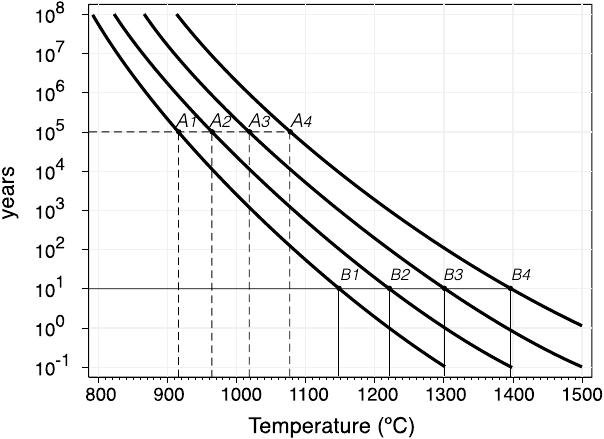
Figure 1. Time-temperature equivalences for Pb diffusion in zircon. The t-T coordinates along the same line result in identical diffusion profiles across two domains with different Pb concentration. The only difference between the four curves is they are suitable for different t-T combinations. For example, heating at 915 °C for 10 5 years (point A 1 ) is equivalent to heating at 1138 °C for 10 years (point B 1 ), or heating at 1177 °C for 10 5 years (point A 4 ) is equivalent to heating at 1396 °C for 10 years (point B 4 ). Calculations were done with the COMSOL TM 58 software using Cherniak and Watson Arrhenius equation: DPb = 1.1 × 10 − 1 exp ( − 550 ± 30 kJ mol − 1/RT) m 2 sec − 1 1,2